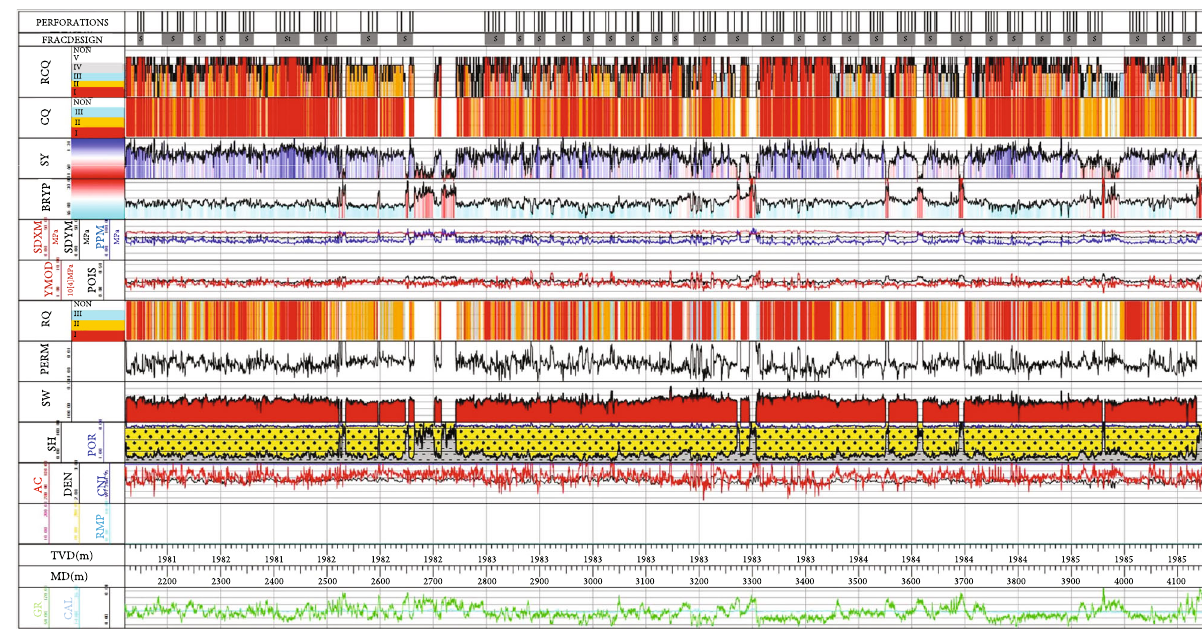
Figure 17: Perforation optimization example of well